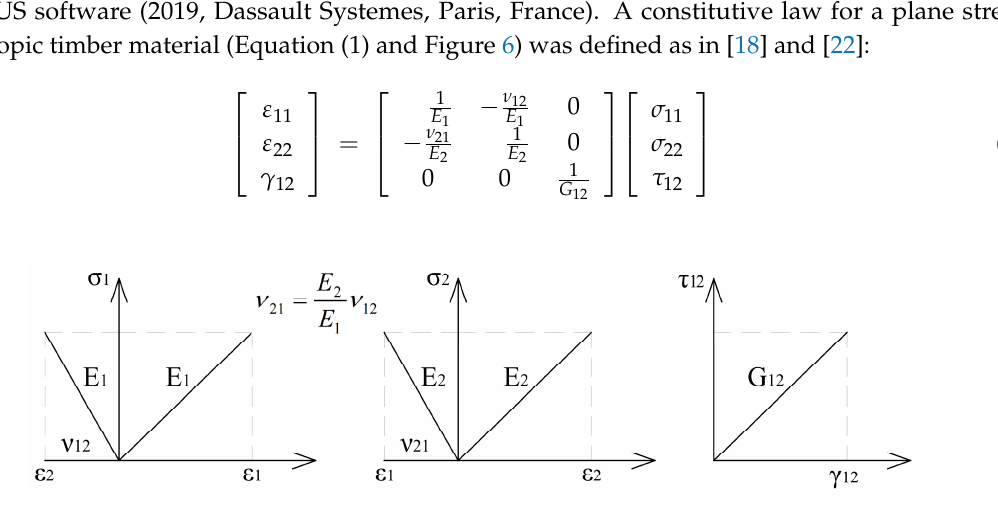
Figure 6. Constitutive law for an elastic orthotropic material model representing timber.